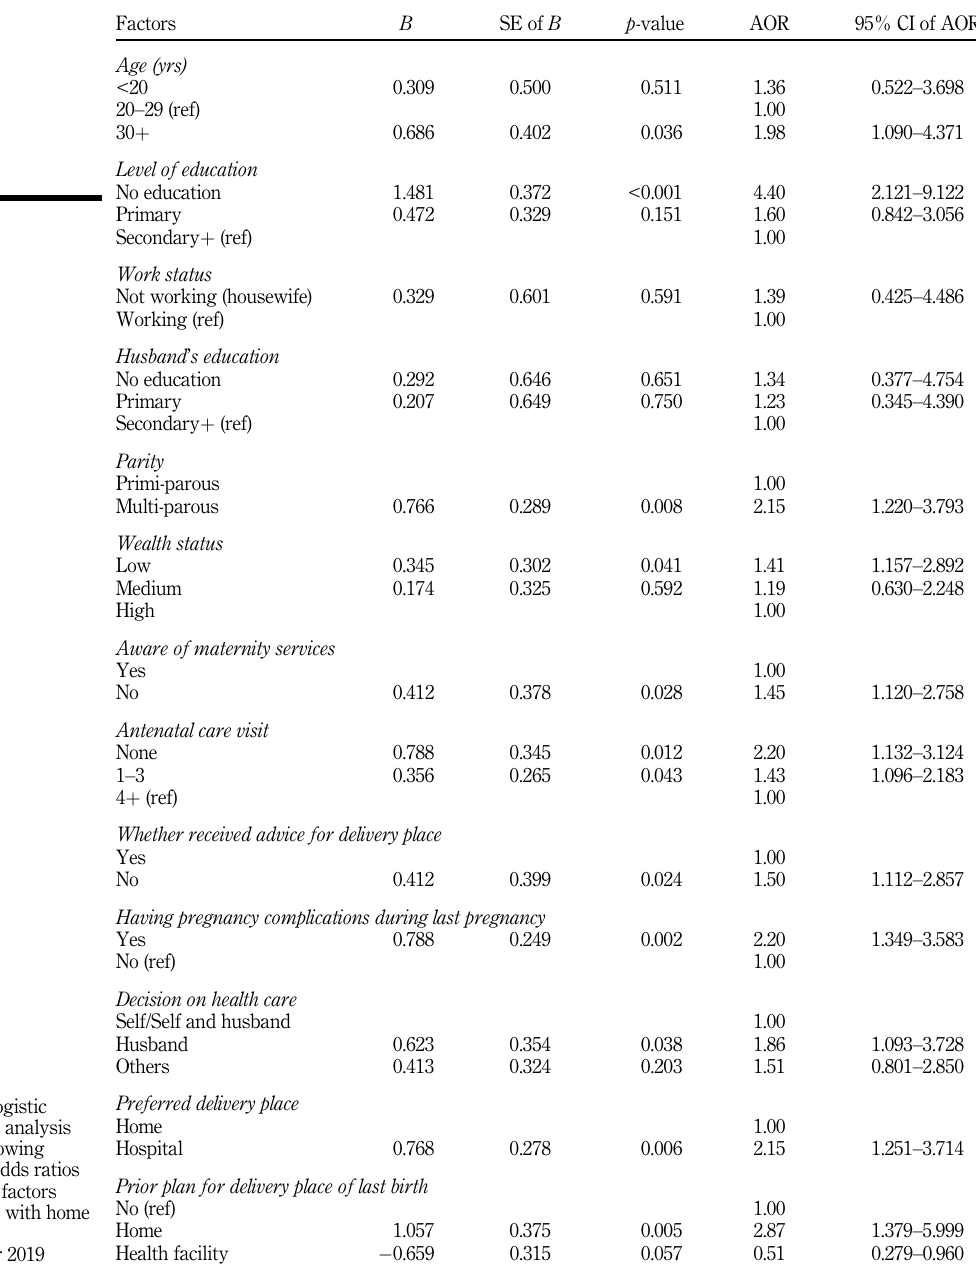
regression analysis results showing adjusted odds ratios (AORs) of factors associated with home